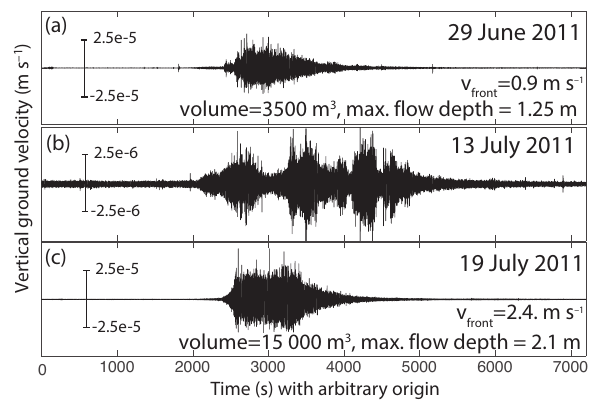
Figure 4. Seismograms of three debris flows recorded at station IGB02. The event on 19 July 2011 (c) is analyzed in the present study. Burtin et al. (2013) focused on the event on 13 July 2011 (b) . Note the different y scales. Debris-flow parameters in (a) and (c) are calculated following Schlunegger et al. (2009) using unpublished data by the Swiss Federal Institute for Forest, Snow and Landscape Research WSL. All shown time series were filtered between 0.5 and 5Hz.